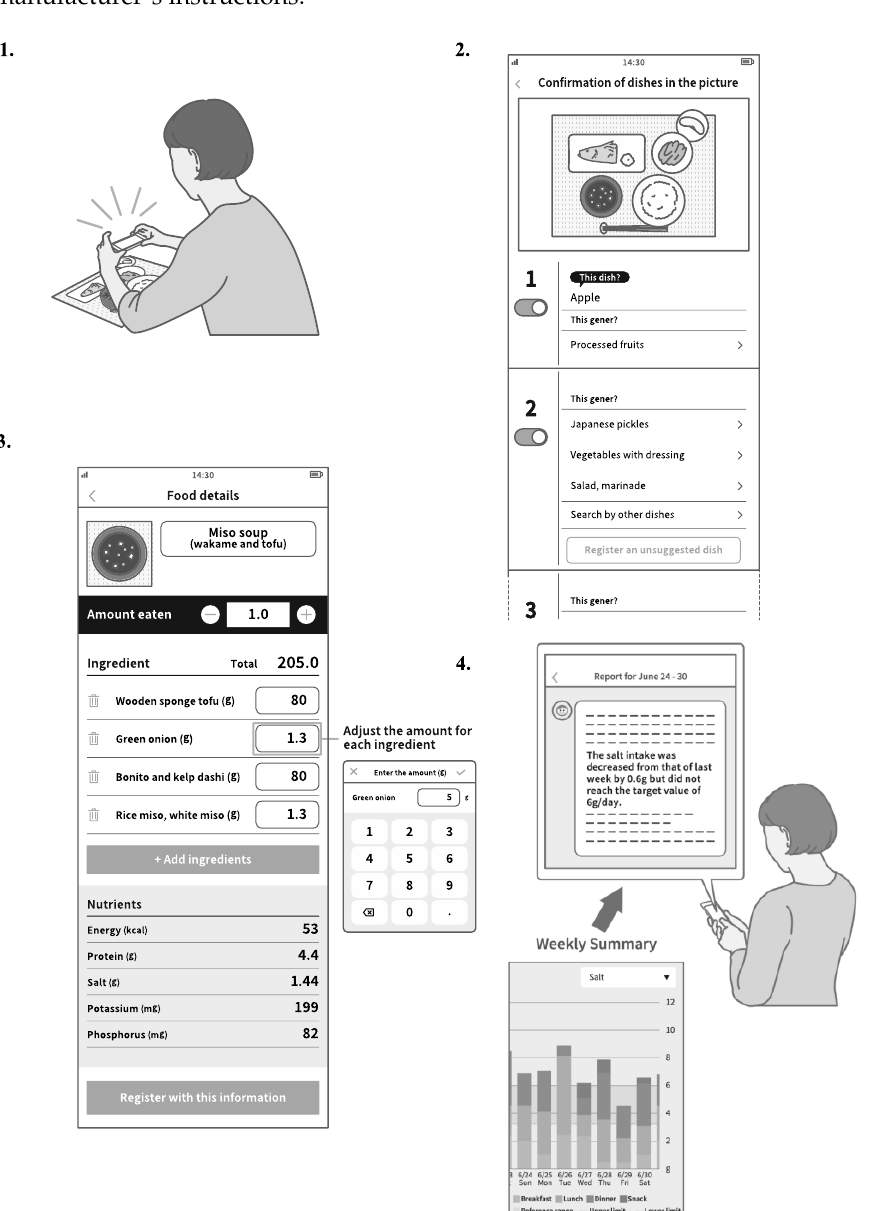
Figure 2. The flow of how to use the artificial intelligence-powered smartphone application,